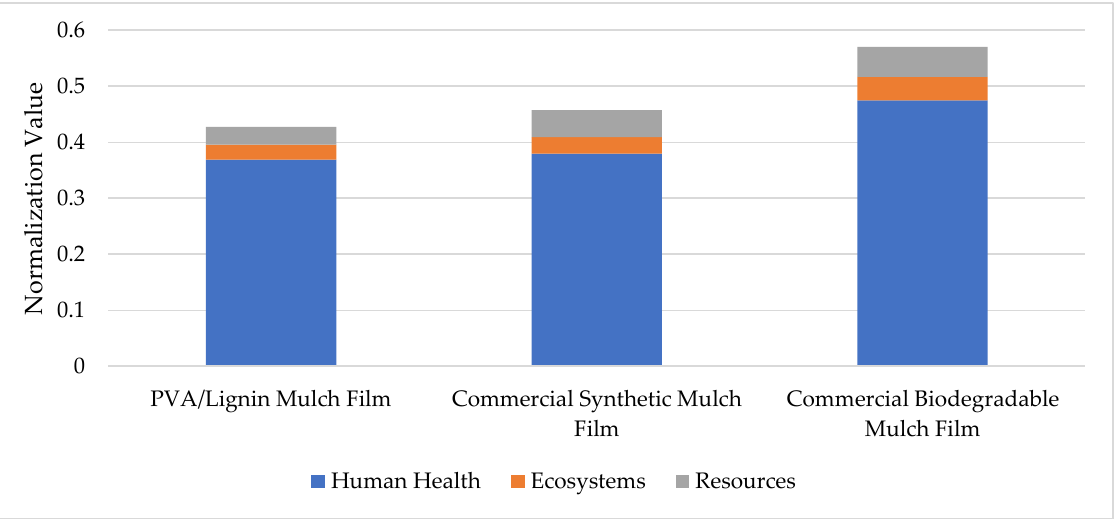
Figure 14. Endpoint impact categories of mulch film PVA with lignin (40PVA/60LN) compared to PVA mulch film, commercial synthetic, and biodegradable mulch films based on the ReCipe Endpoint (H) method.